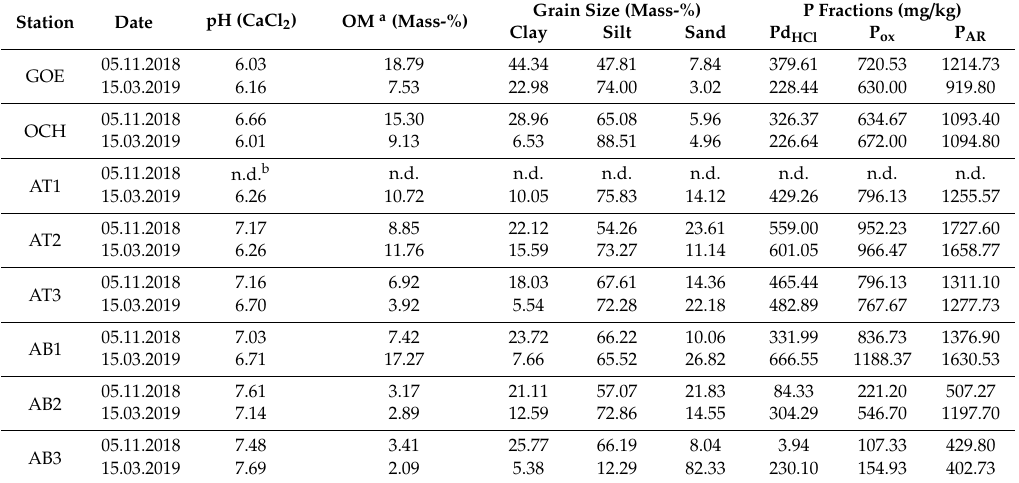
Table 2. General sediment